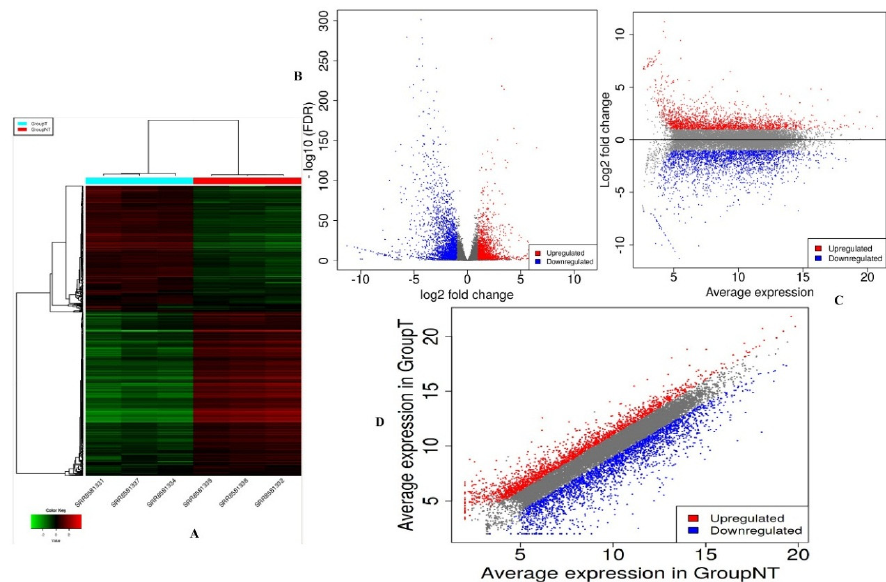
Figure 2. Heatmap and plots of differentially expressed genes in comparison-I ( A ) Heatmap build with top 1000 differentially expressed genes, ( B ) volcano plots with differentially expressed genes (DEGs), ( C ) MA plot with DEGs and ( D ) scattered plots with DEGs).